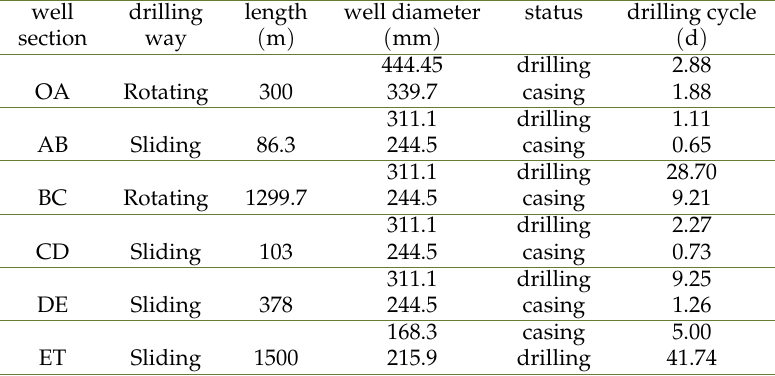
Table 8. Expected drilling time of conventional six-section well path